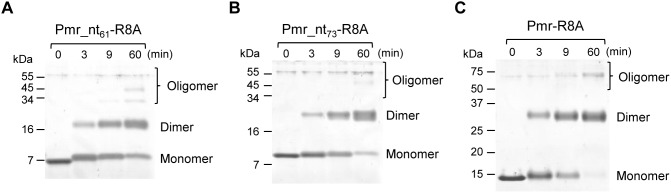
Effect of amino acid substitution on the homo-oligomerization capacity of Pmr_nt61, Pmr_nt73, and Pmr.Tricine-SDS-PAGE profiles of Pmr_nt61-R8A (A), Pmr_nt73-R8A (B), and Pmr-R8A (C) after chemical cross-linking are shown. The analyses were performed using DMS as a cross-linker. Numbers indicate incubation durations (min).